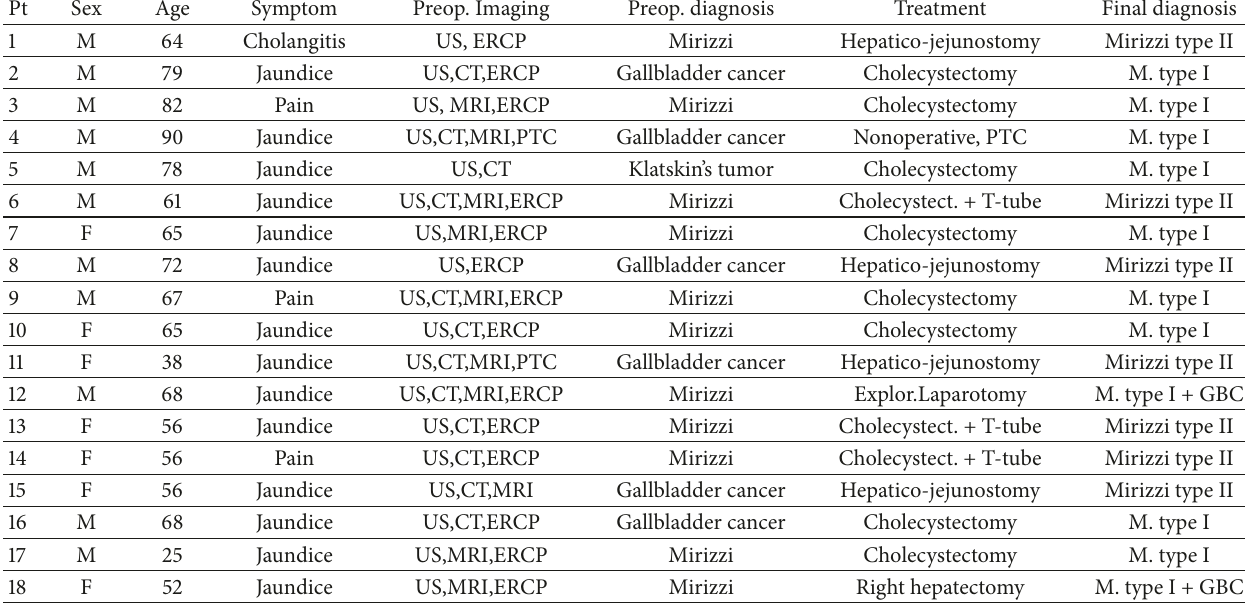
Table 1: Clinical data